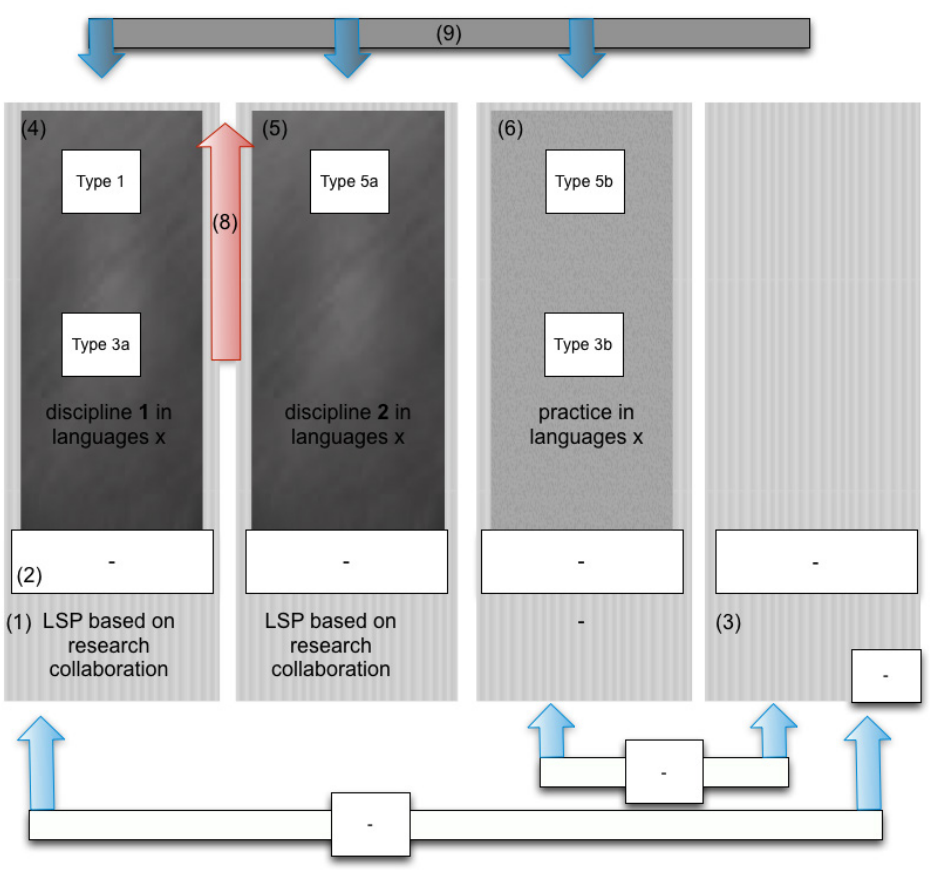
Fig. 11: transdisciplinary research project in the inception